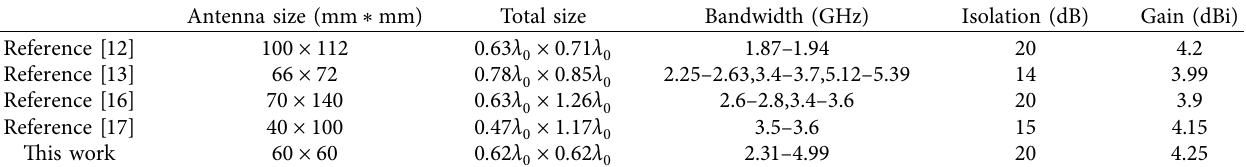
Table 2: Performance comparison with previous